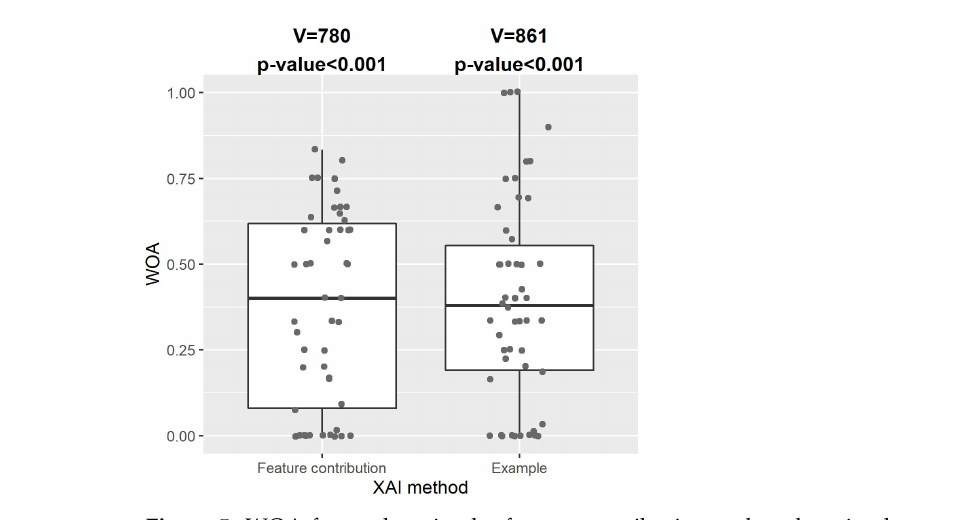
Figure 5. WOA for explanation by feature contribution and explanation by example. This figure shows that our CDSS with either type of explanation has a significant impact on the decision-making (WOA significantly greater than zero).